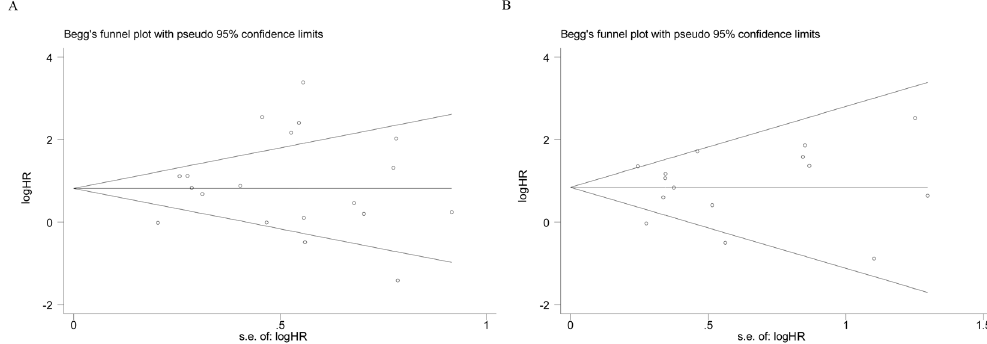
Figure 3. Funnel plots of the prognostic effect of CTCs detected in the peripheral blood on the disease progression ( A ) or survival ( B ) in patients with non-metastatic